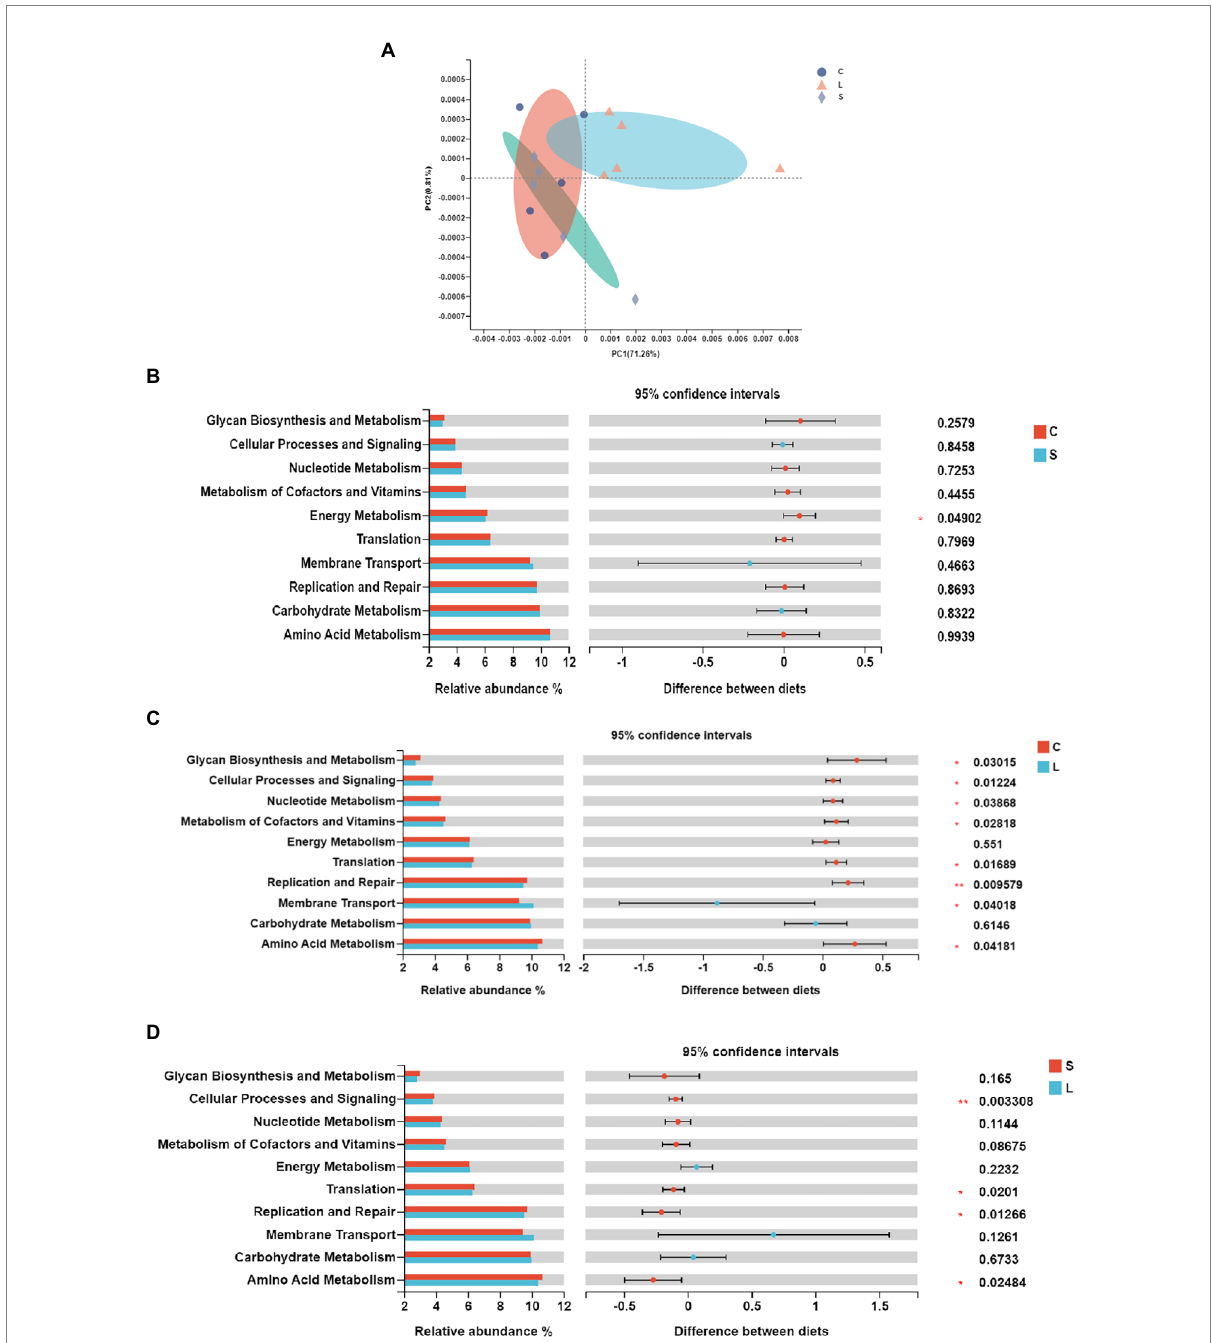
FIGURE 2 Principal coordinate analysis (A) and pairwise comparison (B–D) of the KEGG pathways of the bacteria in the rumen fluid of dairy cows after 48 h in vitro fermentation with two glucogenic (C, S) and a lipogenic (L) diet. (B) C vs. S; (C) C vs. L; and (D) S vs. L. Diets: C, corn and corn silage diet; L, sugar beet pulp and alfalfa silage diet; and S, steam-flaked corn and corn silage